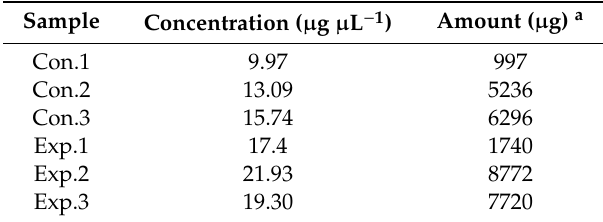
Table 1. Summary of protein quantifications in C. vulgaris .